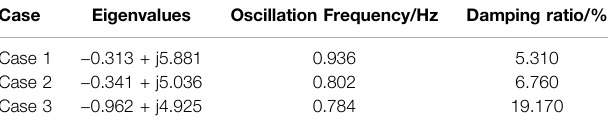
TABLE 4 | Variations of the region oscillation mode.